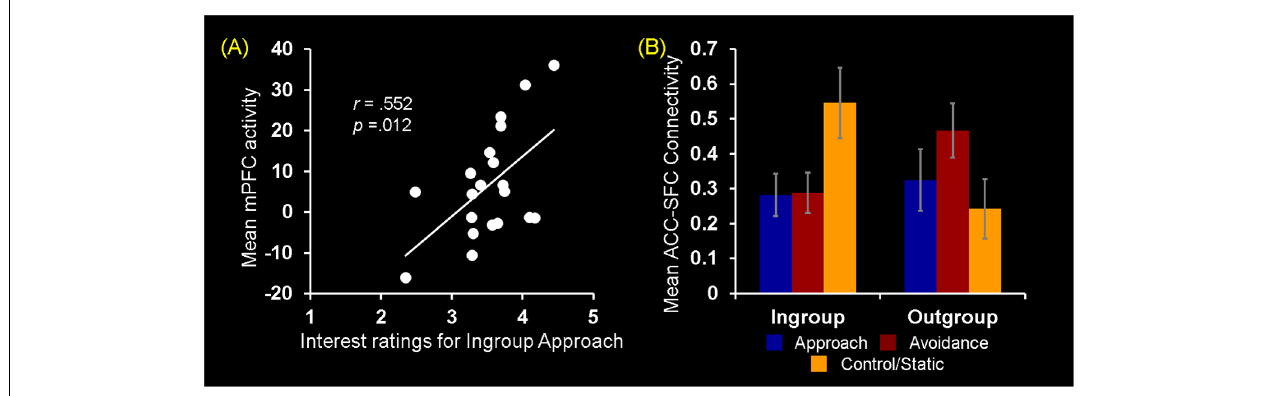
FIGURE 5 | Neural ingroup bias as reflected in brain-behavior covariation and functional connectivity. (A) Brain-behavior covariation analyses identified a significant positive association between differential mPFC activity for ingroup approach vs. static behaviors ( y -axis) and the interest ratings for ingroup approach behaviors ( x -axis). A similar but slighltly weaker relationship was also identified by using the average of interest and competence ratings [ r (18) = 0.496, p = 0.026]. (B) Analyses of whole-brain functional connectivity using as a seed the peak voxel ( x = 0, y = 20, z = 21) of the ACC cluster shown in Figure 4A identified the right SFC region showing a significant Behavior × Host Race ANOVA interaction. Post hoc analyses revealed that the ACC-SFC connectivity significantly increased for observing ingroup static compared to ingroup approach [ t (19) = 2.65, p = 0.02] and avoidance [ t (19) = 2.84, p = 0.01] behaviors. In contrast, there was no difference in connectivity between the two regions for observing outgroup social encounters. Values on the y -axis represent the magnitude of correlation ( Z -values) between activity in the ACC seed region and mean activity within the right SFC cluster calculated on the basis of trial-by-trial variability for each participant. Error bars indicate the standard error of the mean for each